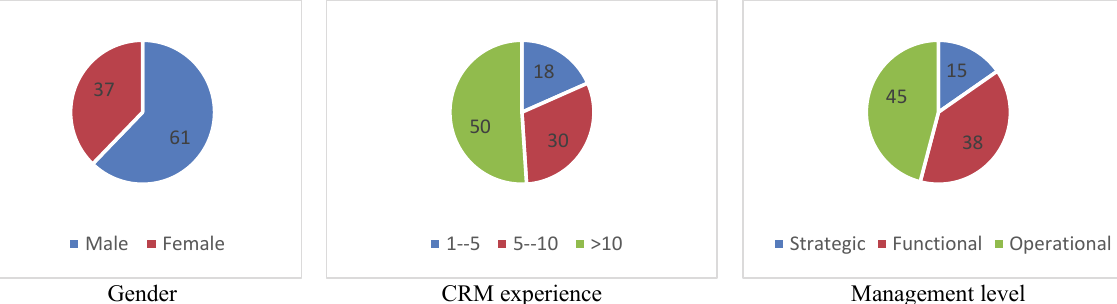
Fig. 1. Personal characteristics of the participants